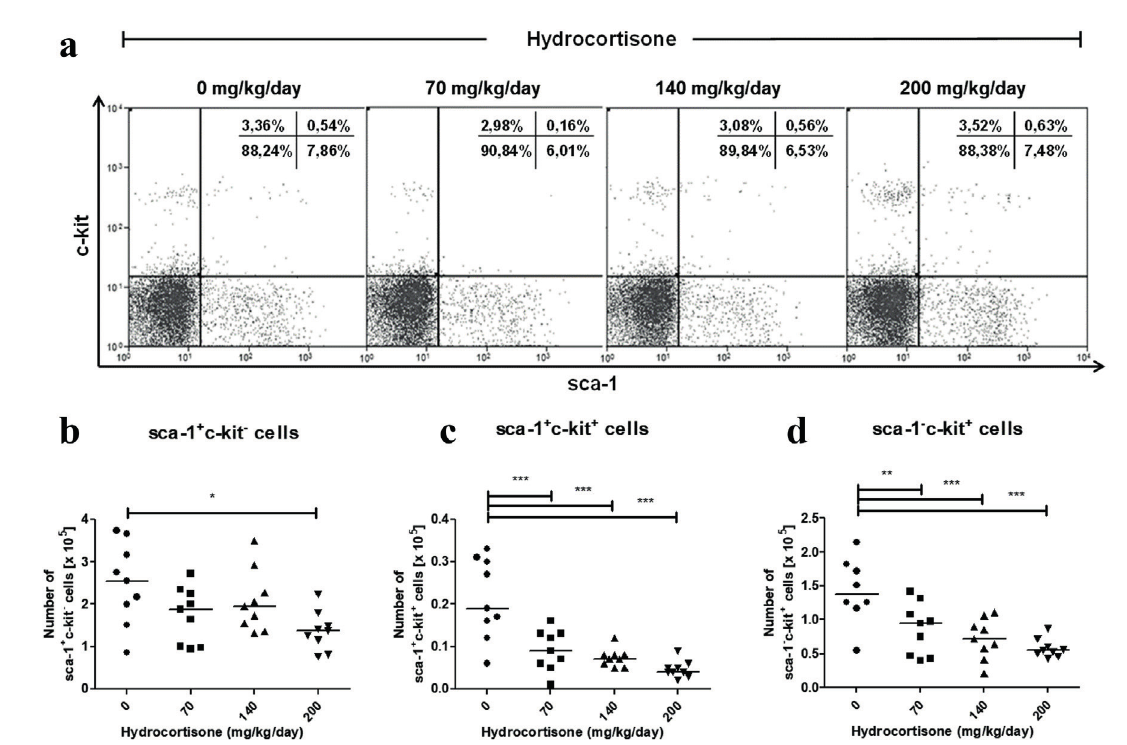
Figure 2 - Effect of in vivo treatment with hydrocortisone on B cell progenitors. Mice were injected with diluent or hydrocortisone (70, 140 or 200 mg/kg/day) for 3 consecutive days. In the next day, bone marrow cells were counted and stained with monoclonal antibodies for sca-1 and c-kit molecules for analysis by flow cytometry. ( a ) Percentage of hematopoietic progenitor subsets, ( b ) total number of sca-1+c-kit-, ( c ) sca-1+c-kit+ and ( d ) sca-1-c-kit+ cells. Line represents the median, (*) represents values of p<0.05, (**) p<0.01 and (***) p<0.001, according to the statistical test. Results are representative of 3 independent experiments with 3 mice/group